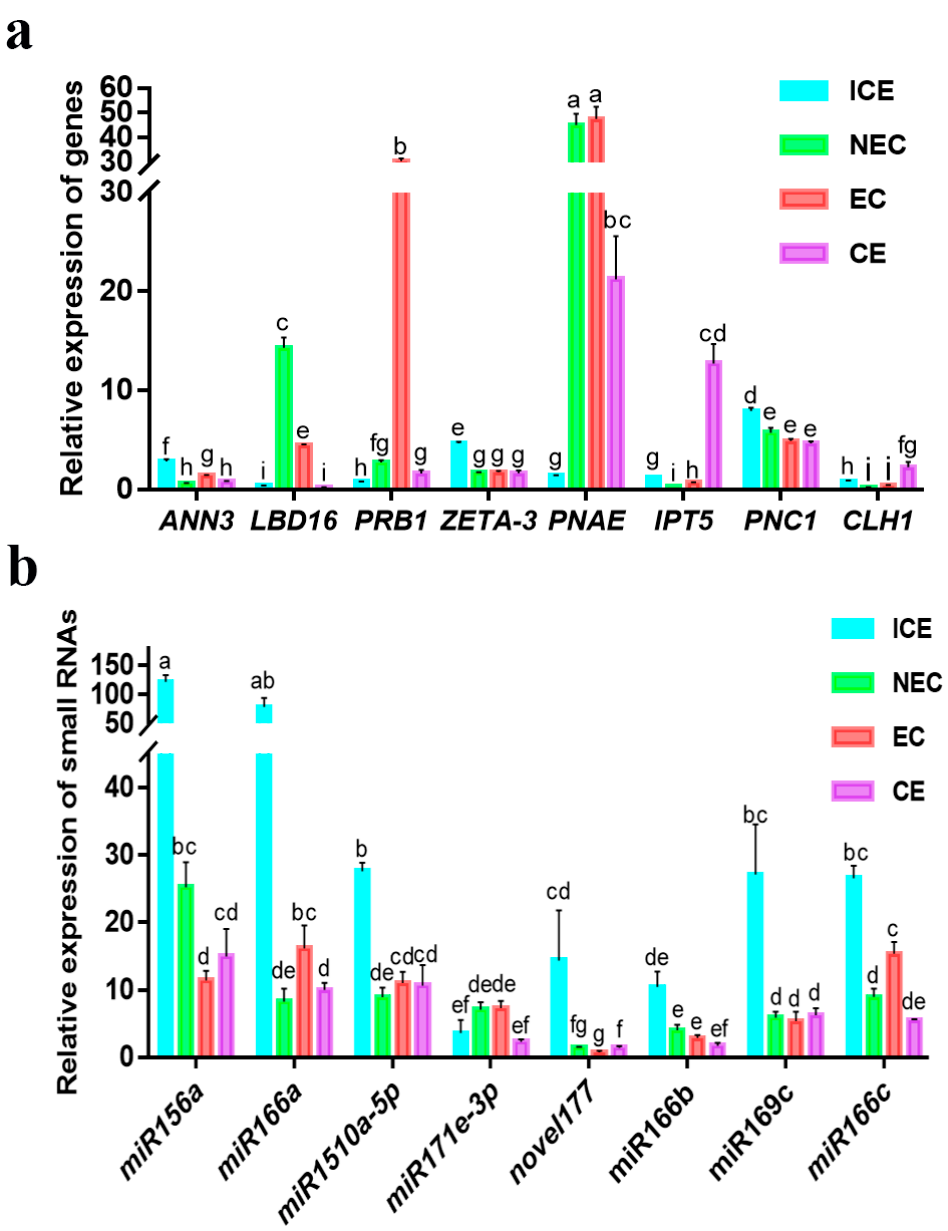
Figure 10. Relative expression of genes and miRNAs during cut cotyledon (ICE), non-embyogenic callus (NEC), embryogenic callus (EC), cotyledon embryo (CE) phases. ( a ) The relative expression of DEGs; ( b ) The relative expression of miRNAs. genes and miRNAs calculated by the equation = 2 −ΔΔ Ct , The 18sRNA is housekeeping gene for gene expression detection, and the U6 gene is house- keeping gene for miRNA expression detection. The different letters represent significant differences ( p < 0.05, (ANOVA)).